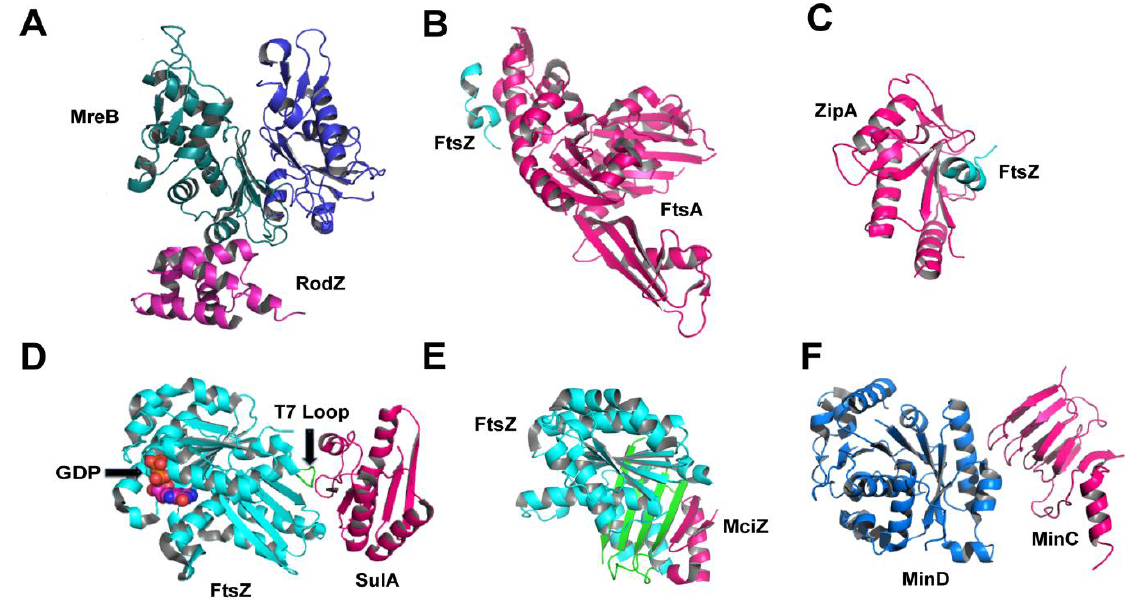
Figure 4. Protein interactions involving cytoskeletal proteins that play key roles in cytoplasmic and membrane-embedded PG biosynthesis steps. ( A ) MreB:RodZ from T. maritima (2WUS), where MreB’s subdomains IA and IIA are shown in blue and green, respectively; ( B ) FtsA:FtsZ (res 338–351) from T. maritima (4A2A); ( C ) ZipA:FtsZ (res 367–383) from E. coli (1F47); ( D ) SulA:FtsZ from P. aeruginosa (1OFU); ( E ) MciZ:FtsZ from B. subtilis (4U39), where MciZ‘s β -hairpin completes FtsZ’s 4-stranded sheet ; ( F ) MinC:MinD from A. aeolicus (4V02).